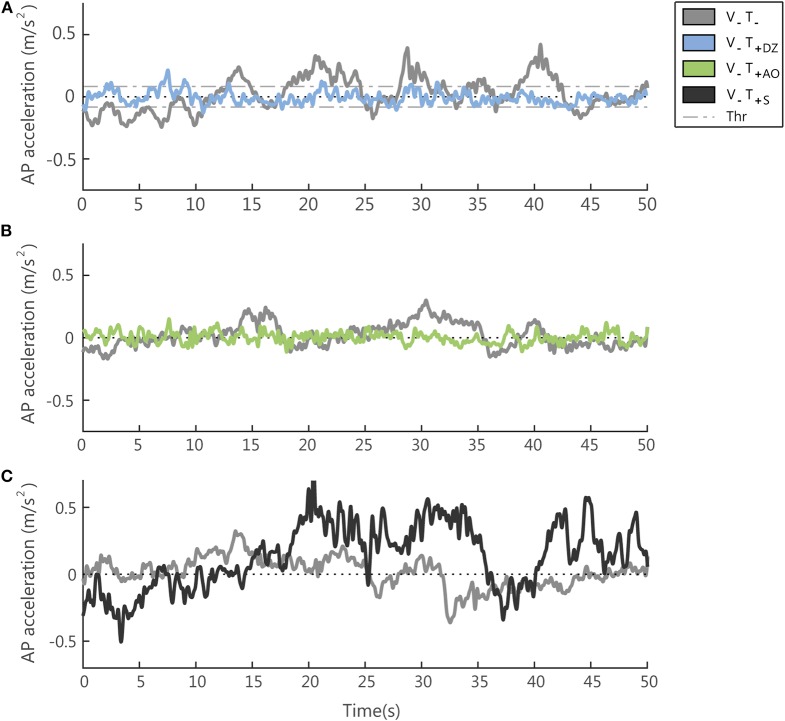
Examples of the accelerometer signal (low-pass filtered, cut off frequency 3.5 Hz) in absence (V−T−) and presence (V−T+) of supplemental vibrotactile feedback. Each panel compares, for one typical participant, the accelerometric signal in the (V−T−) condition with the same signal measured in the three conditions with vibration on: the dead-zone method (V−T+DZ) in (A) (note that the dead zone is delimited by the threshold (Thr), i.e., the two dashed lines); the always on method (V−T+AO) in (B); the sham feedback (V−T+S) in (C).